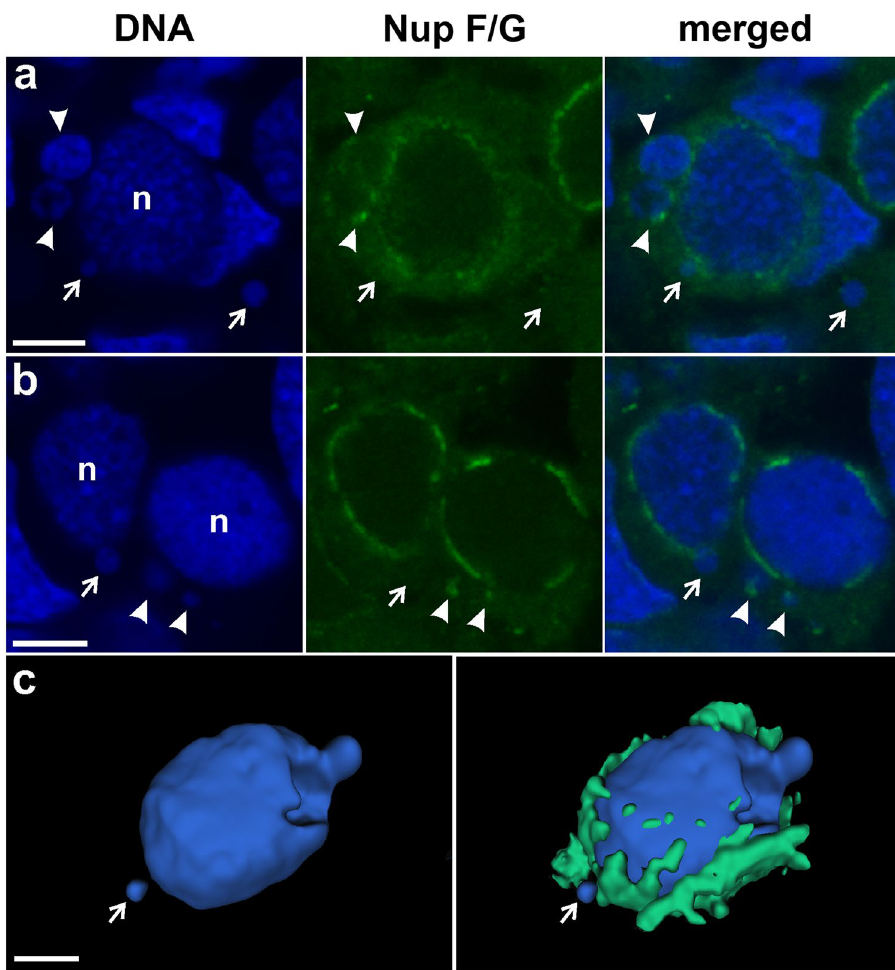
Figure 2. Level of nuclear pore complex proteins is reduced in nuclear envelopes of micronuclei in contrast to the main nucleus. Immunofluorescent staining of frozen tissue sections of ovaries from P. esculentus diploid female at 29 Gosner stage: nuclear pore complex proteins, NPC (Nup F/G, green), DNA counterstained with DAPI (blue). Germ cells in the centre of the images (n) have higher expression level of NPC proteins in the nuclear envelope in contrast to somatic cells, visible in the surrounding tissue. The NPC proteins staining pattern in MN is patchy, dotted (arrowhead) or absent (arrow). ( a ) Gonocyte with 3 micronuclei of various sizes. Micronucleus in the middle has patchy NPC proteins staining similar to main nucleus. ( b ) On the left side is gonocyte with MN devoid of NPC proteins (arrow), on the right side gonocyte with dotted NPC proteins signals in two MN of various sizes (arrowheads). Confocal images represent projection of 2 z-sections ( a ) or single z-section ( b ) (0.46 µ m). ( c ) 3D model of reconstructed fluorescent signal volumes from cell visible in Fig. 9d, NPC proteins (green) and DNA (blue). Note that NPC signal is discontinuous probably due to differential distribution of nuclear pore complexes in the nuclear envelope and threshold settings excluding cytoplasmic signal. Scale bars 5 µ